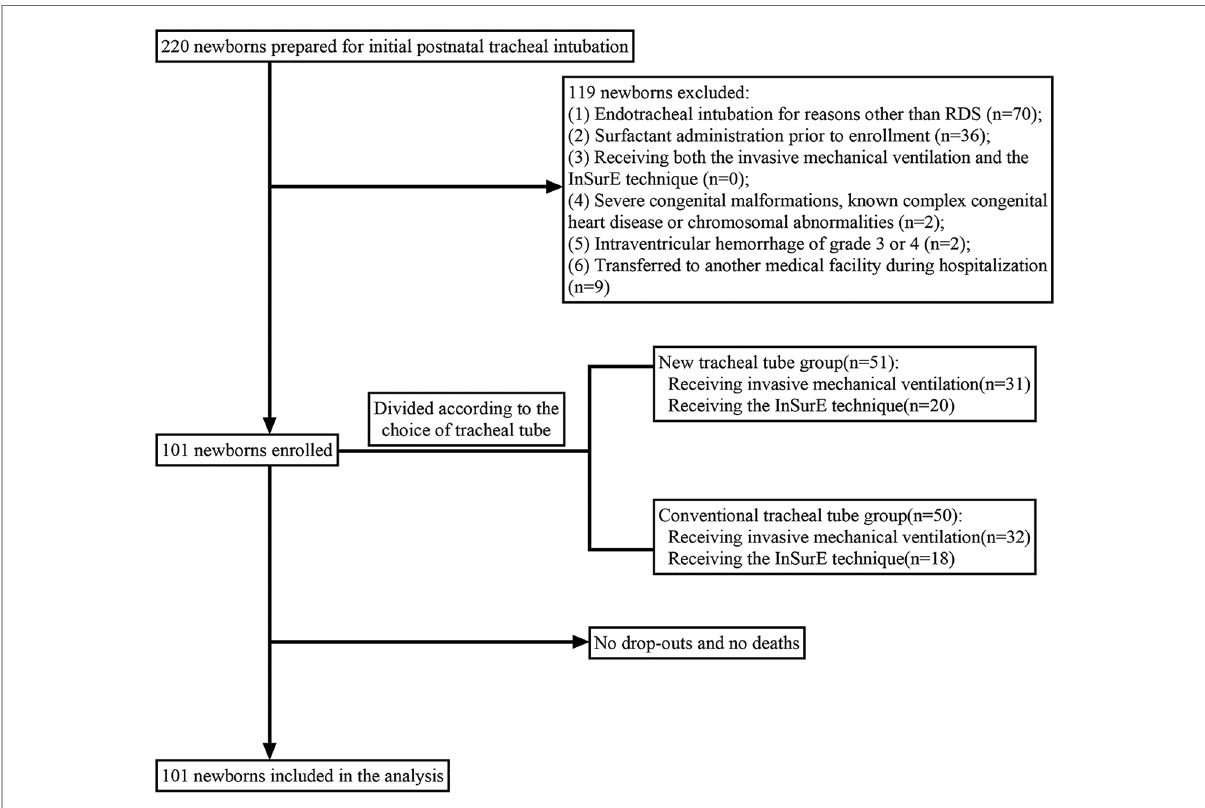
FIGURE 2 Flow diagram of